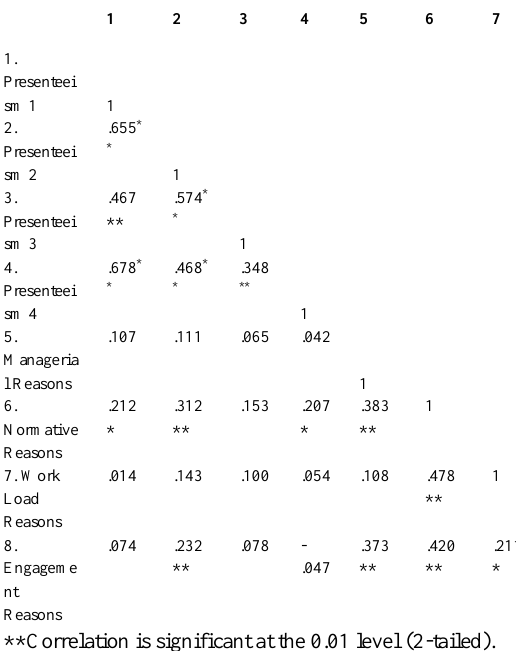
Table 19: Correlations among Different Measures of Presenteeism and